Question: What type of chart is this?
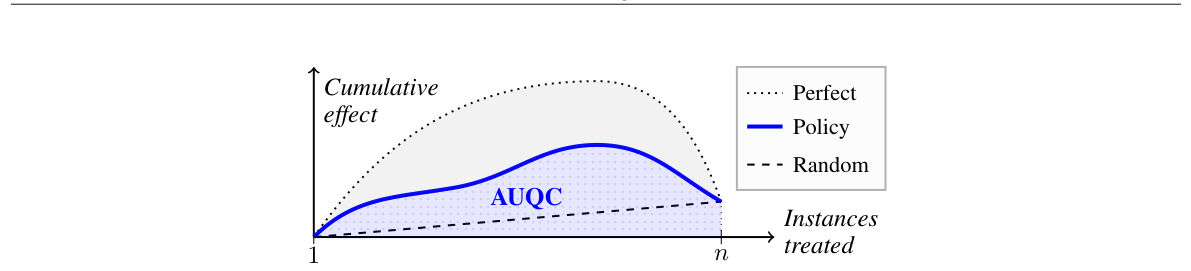
Answer: line